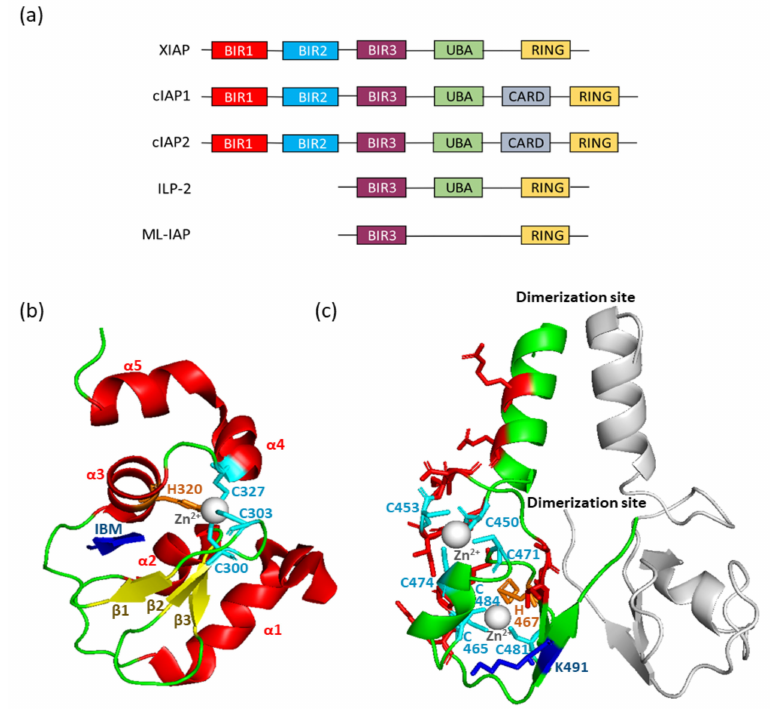
Figure 1. ( a ) Structure of Inhibitor of Apoptosis (IAP) E3-ubiquitine ligases. BIR: Baculovirus